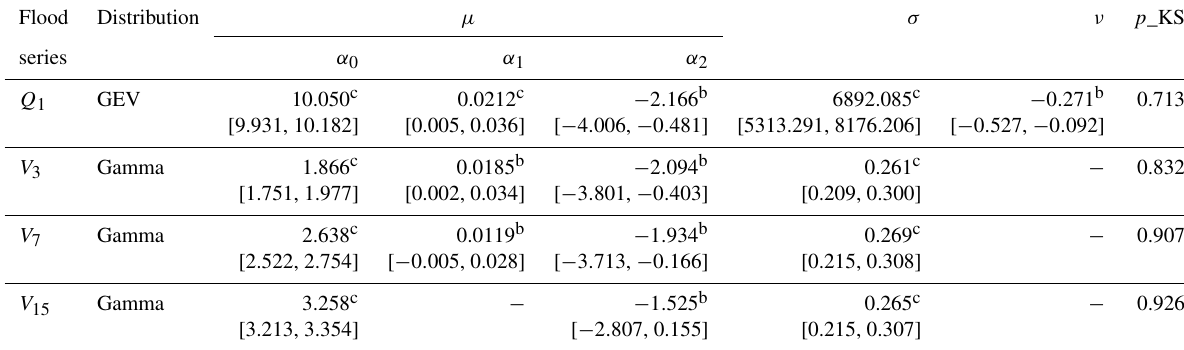
Table 2. Results of nonstationary analysis for the marginal distributions of (Q 1 , V 3 , V 7 , V 15 ) . Flood Distribution